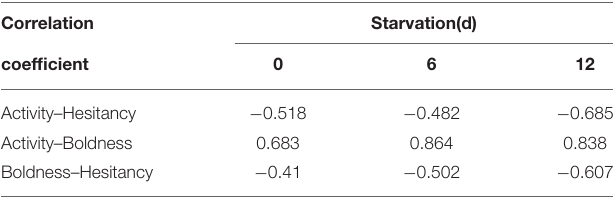
TABLE 1 | Correlation analysis between different personality characteristics of swimming crab under starvation